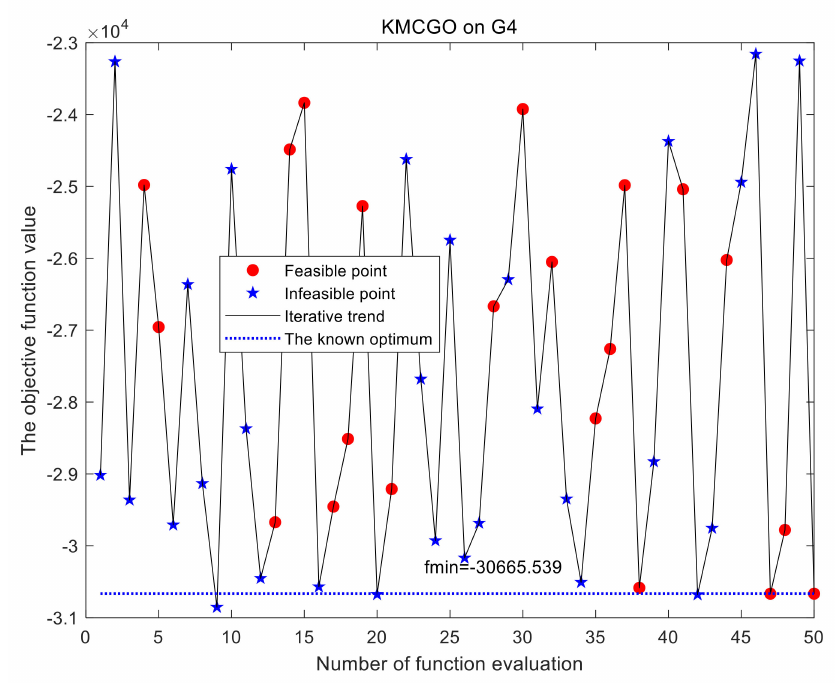
Figure 9. Iteration result of the G4